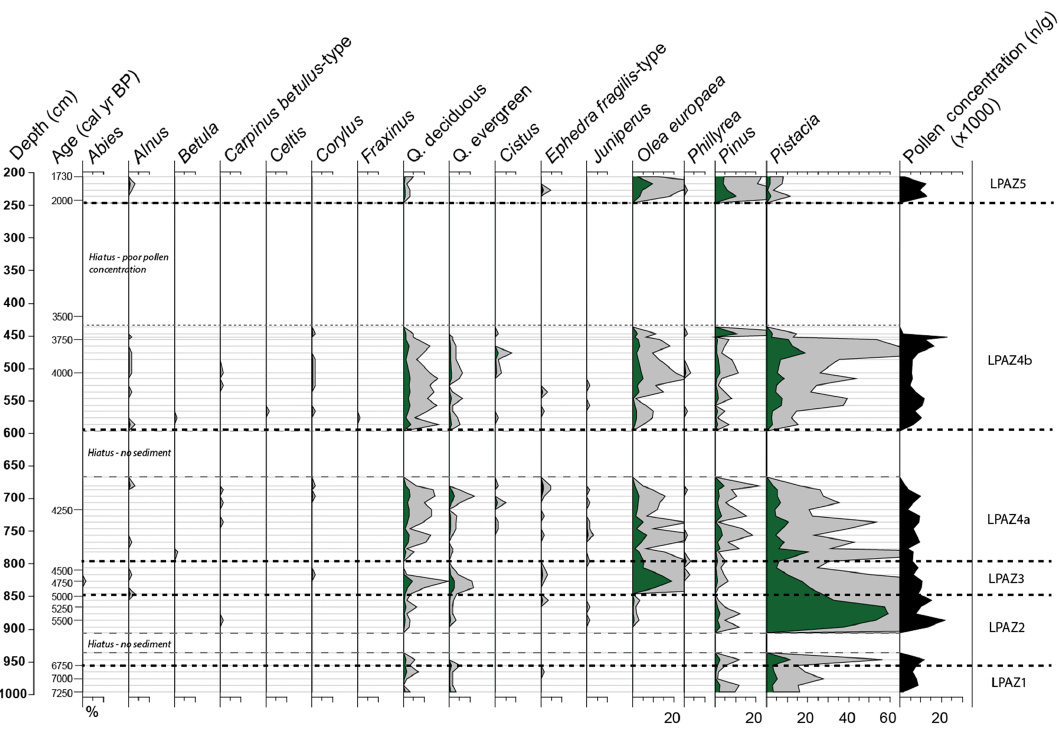
Figure 4. Burmarrad pollen percentage diagram versus depth: trees and shrubs. The pollen percentages are calculated using the pollen sum of all terrestrial pollen counted; it excludes Cyperaceae and other aquatic/hygrophilous species, NPPs, and undetermined/indeterminable grains.